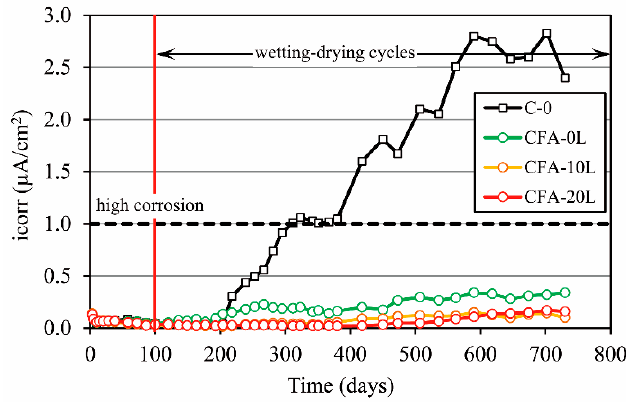
Figure 12. Evolution of the corrosion rate (i corr ).